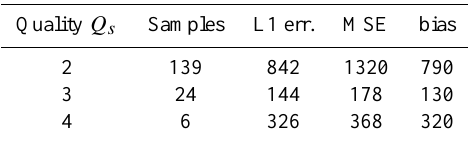
Table 2. Short motion magnitude error statistics (the errors are in